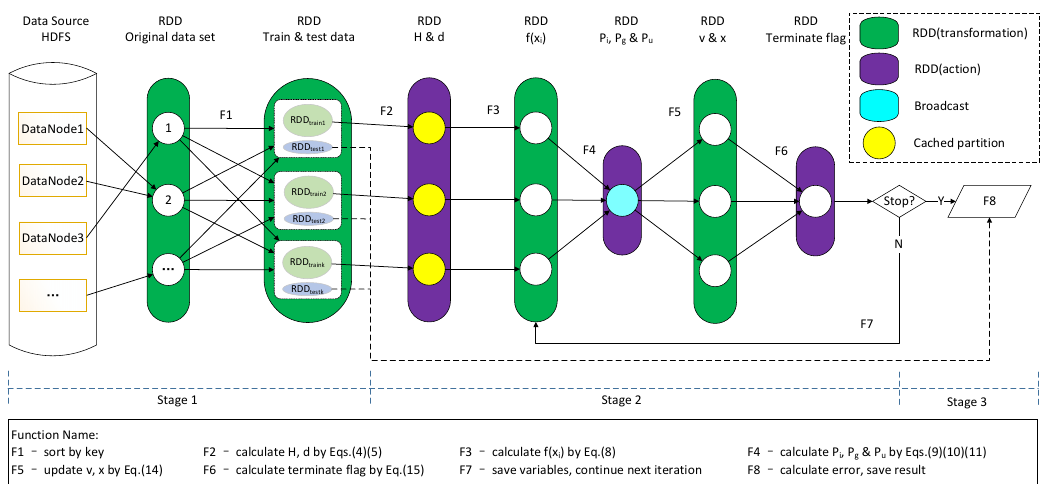
Figure 3. Training processing of parallelized PSO ‐ based ESN algorithm.